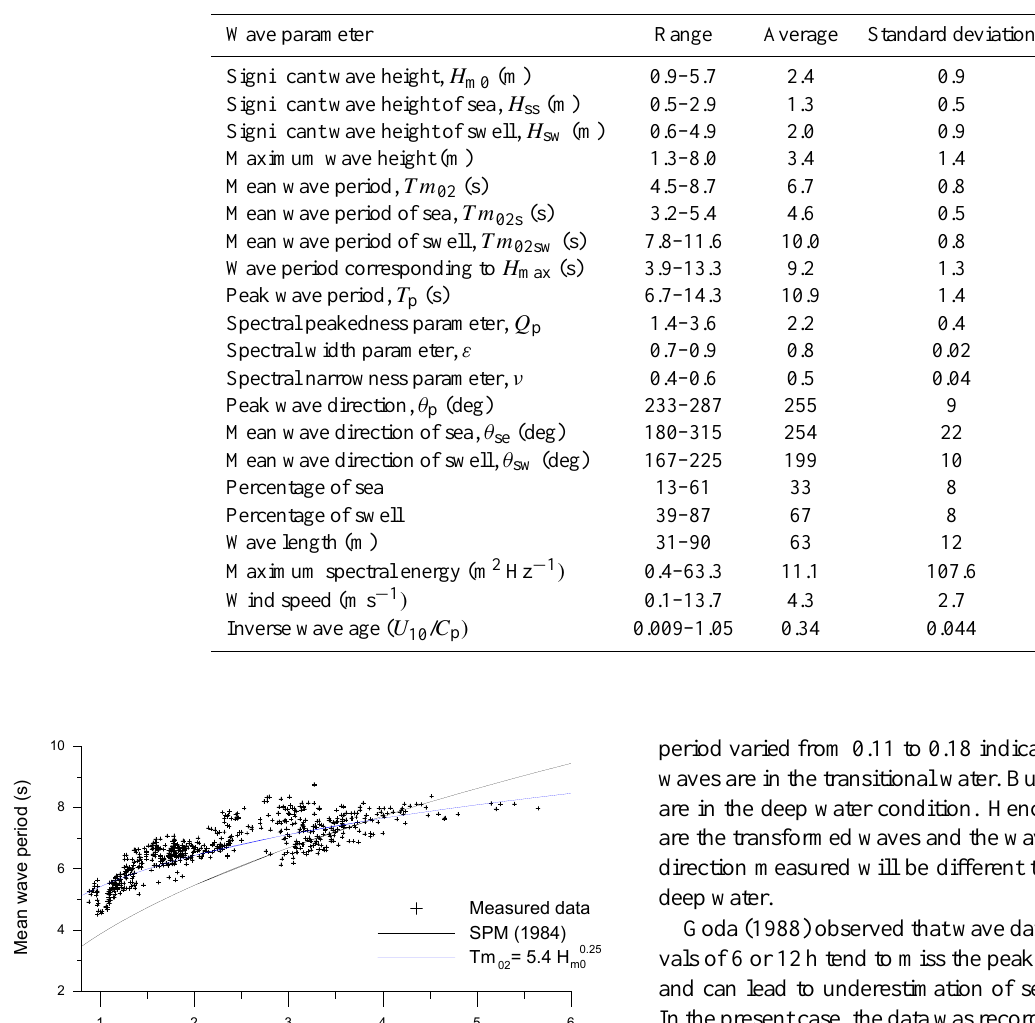
Table 1. Range and average value of wave parameters during the onset of summer monsoon at 14m water depth.